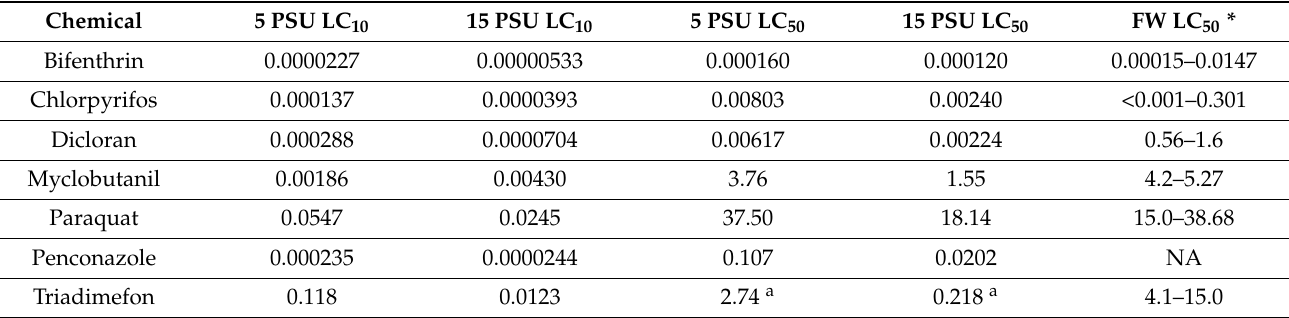
Table 3. LC 50 and LC 10 values for all tested compounds at 5 PSU and 15 PSU. All concentrations reported as mg/L (nominal). a Indicates the difference in LC 50 between the two salinities was significant, p < 0.05. * FW LC 50 values from the U.S. EPA ECOTOX database, reporting values for Rainbow Trout (Oncorhynchus mykiss) 96-h acute toxicity tests.